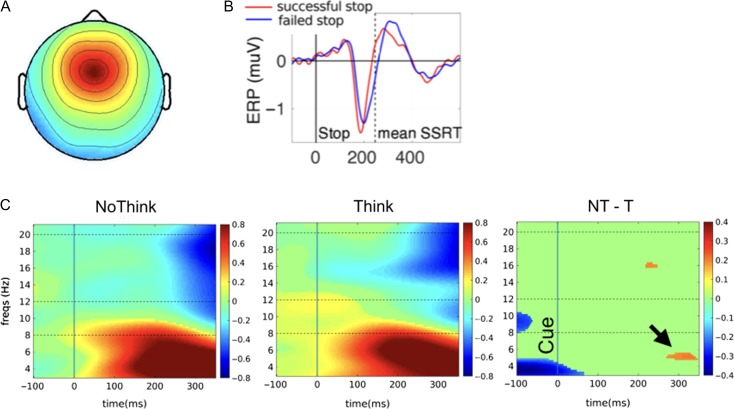
EEG results for the dorsomedial component. (A) The dorsomedial topography representing the cluster mean scalp projection map of automatically clustered dorsomedial components from 36 participants. (B) ERP analysis from this cluster shows the P3 onset latency is earlier for successful vs. failed stop trials, c.f. (Wessel and Aron 2015). (C) ERSP analysis shows there is increased low frequency power for No-Think vs. Think for this component. The plots are FDR corrected for multiple comparisons. Power units are in dB.